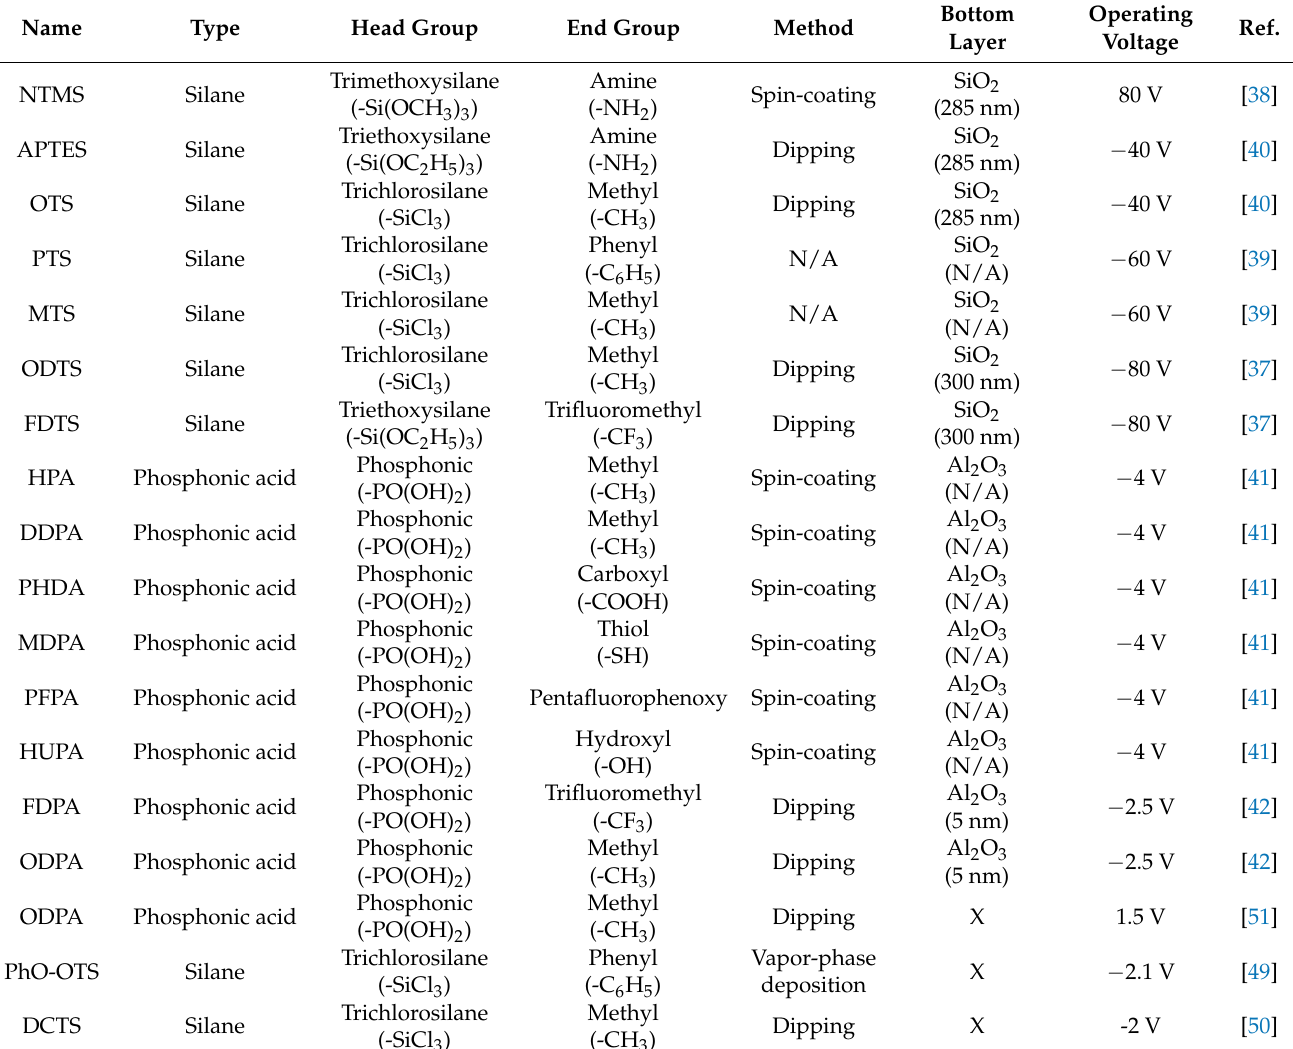
Table 1. Various types of self-assembled monolayers (SAMs) for gate